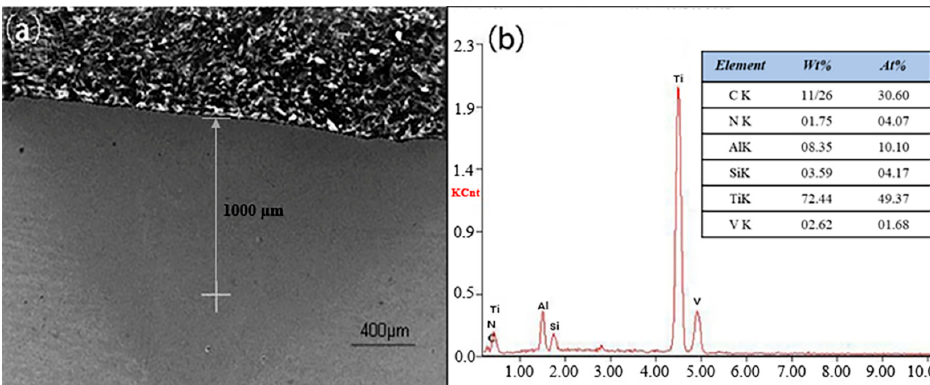
Figure 5. Cross-sectional morphology and point energy spectrum analysis of the wear surface: ( a ) coating cross-section morphology; ( b ) point spectrum analysis.